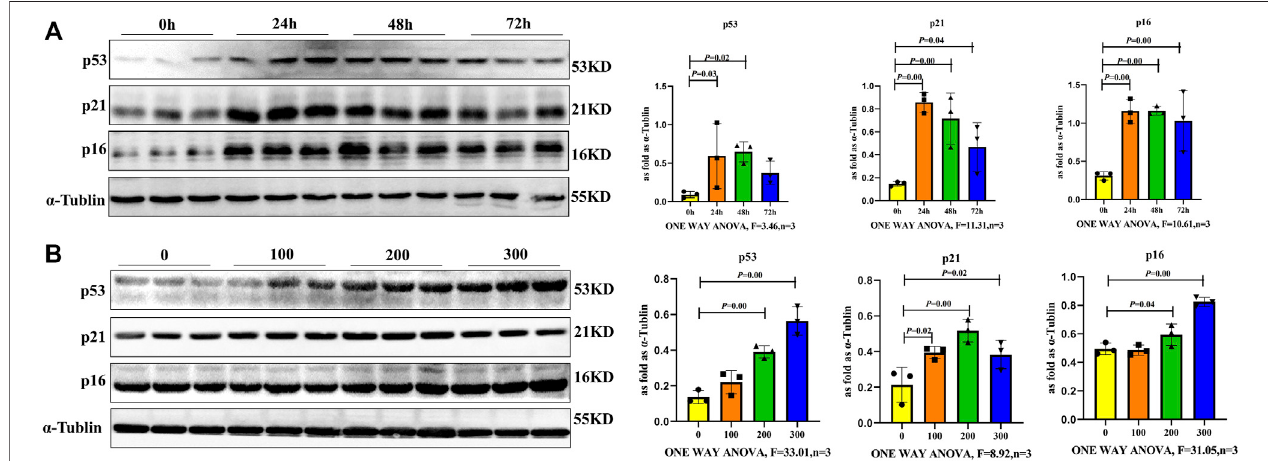
FIGURE 4 | Macrophages exhibited a senescent phenotype after SiO 2 exposure. (A) p16, p21 and p53 expression levels in RAW264.7 cells following 200 μ g/ml SiO 2 exposure for24,48and72 hbywesternblot. (B) p16, p21and p53expression levelsinRAW264.7 cellsfollowingSiO 2 exposure(100, 200,or300 μ g/ml)for24 h by western blot. Data are presented as the mean ± SD. n = 3 per